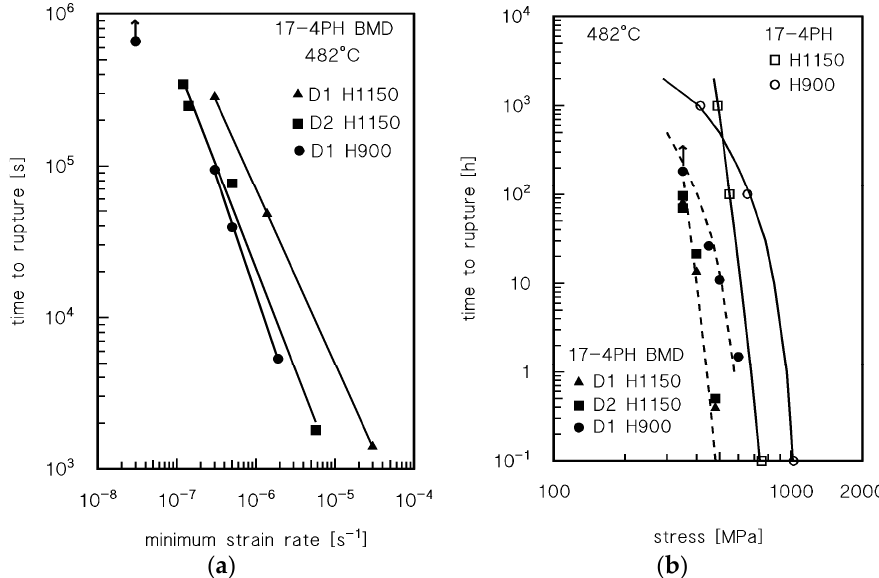
Figure 6. ( a ) Time to fracture (in s) as a function of minimum creep rate; ( b ) time to fracture as a function of stress for the BMD steel and for a similar material processed by traditional technologies (data from [16]).